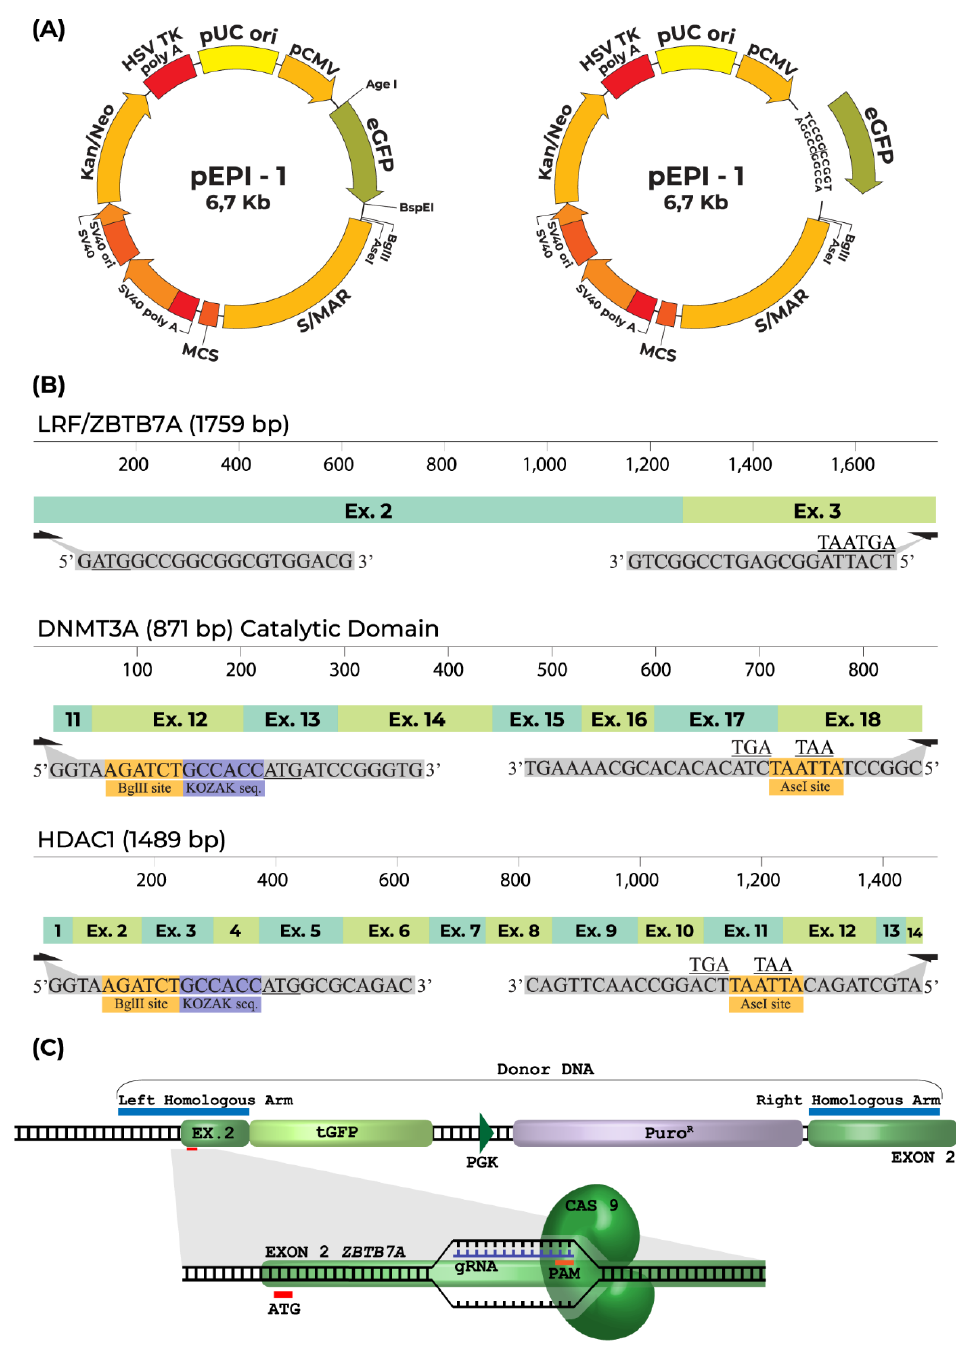
Figure 5. Construction of LRF/ ZBTB7A , DNMT3A, HDAC1 episomal vectors and the LRF/ ZBTB7A knockout CRSPR/Cas9 system. ( A ) Restriction sites for LRF/ ZBTB7A , DNMT3A , HDAC1 insertion into the episomal vector PEPI-1. Reporter gene’s eGFP sequence, between AgeI/BspEI sites, was removed. Arrows indicate the location as well as the orientation of the eGFP and the vector’s functional elements. ( B ) Schematic representation of LRF/ ZBTB7A , catalytic domain of DNMT3 and HDAC1 sequences incorporated within PEPI-1. Kozak sequence and restriction endonuclease sites added (in PCR primers) are marked with orange and blue color respectively. Start and stop codons are underlined. ( C ) Schematic illustration of CRISPR/Cas9 mediated LRF/ ZBTB7A gene knockout through homology-directed repair mechanism. CRISPR/Cas9 cuts the double stranded DNA after first codon (ATG) indicated as a red rectangle. Position of left and right homology arm is indicated with blue rectangle. Edited ZBTB7A locus is